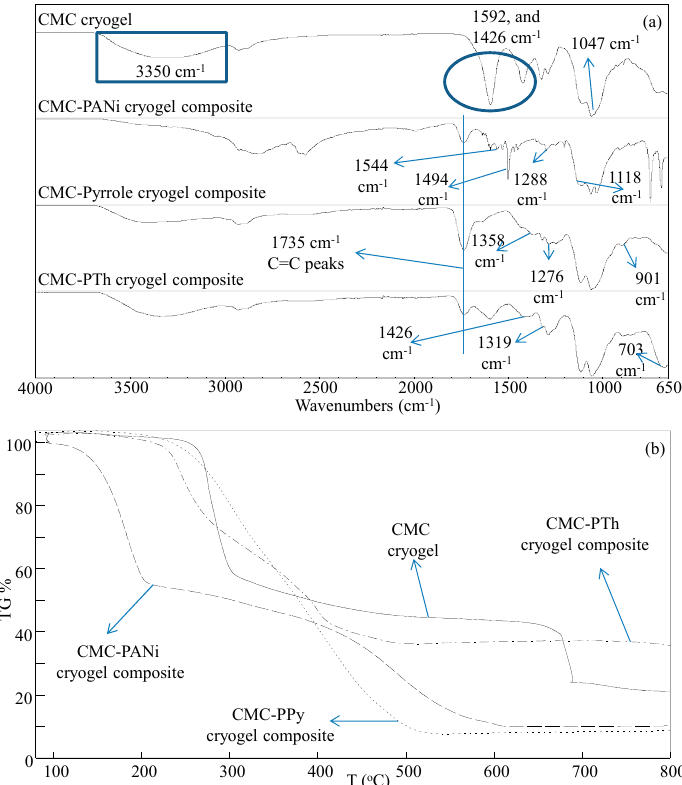
Figure 2. ( a ) Fourier transform infrared (FT-IR) spectrum and ( b ) thermogravimetric analysis (TGA) thermograms of CMC cryogel, CMC–PANi, CMC–PPy, and CMC–PTh cryogel composites.